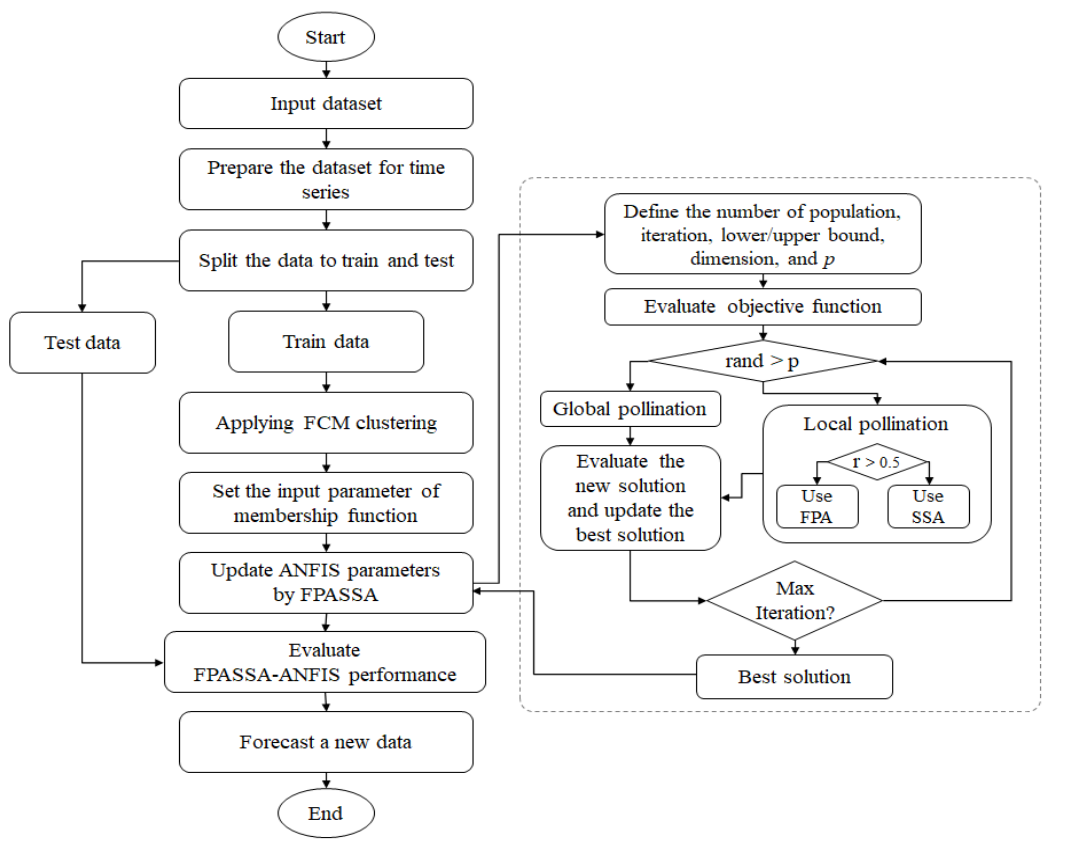
Figure 2. The proposed FPASSA-ANFIS